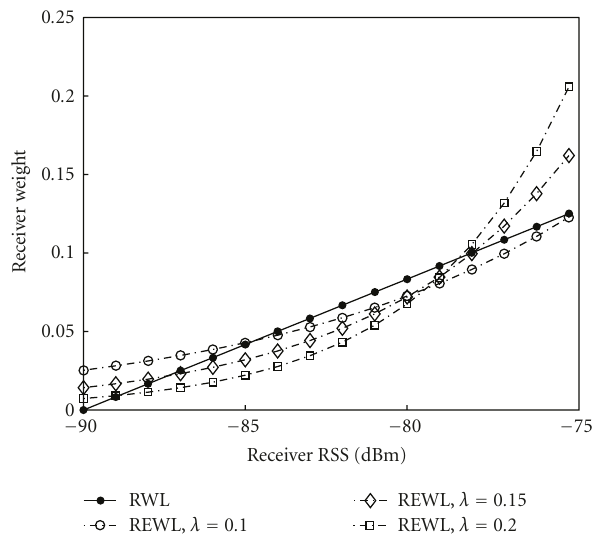
Table 1: Average number of receivers per node